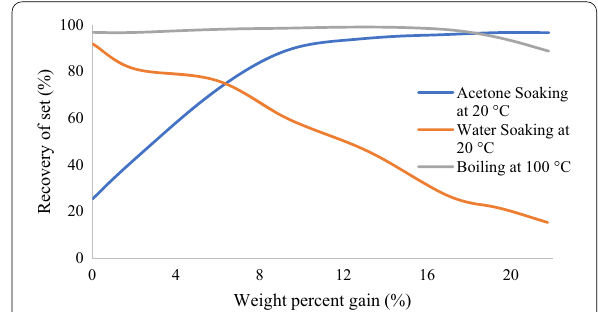
Fig. 12 Recovery of set from water soaking at 20 °C, boiling, and acetone soaking at 20 °C for acetylated timber ( reproduced from Inoue et al. [71])